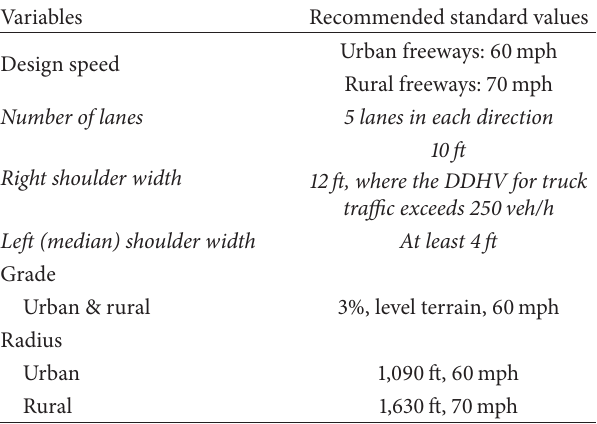
Table 2: Recommendation for geometric standard design